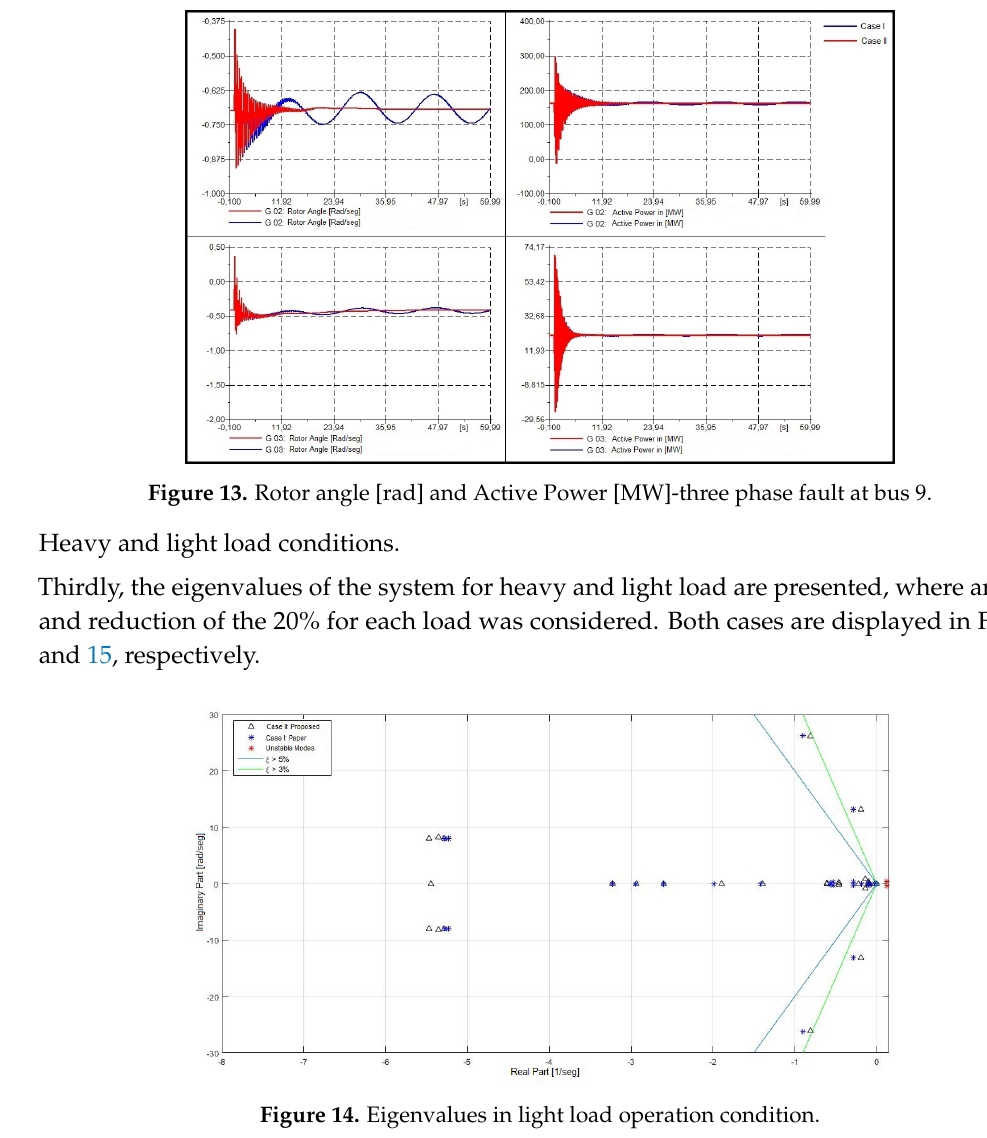
Figure 12. Rotor angle [rad] and Active Power [MW]-three phase fault at bus 7. 3. Three phase fault at bus 9.